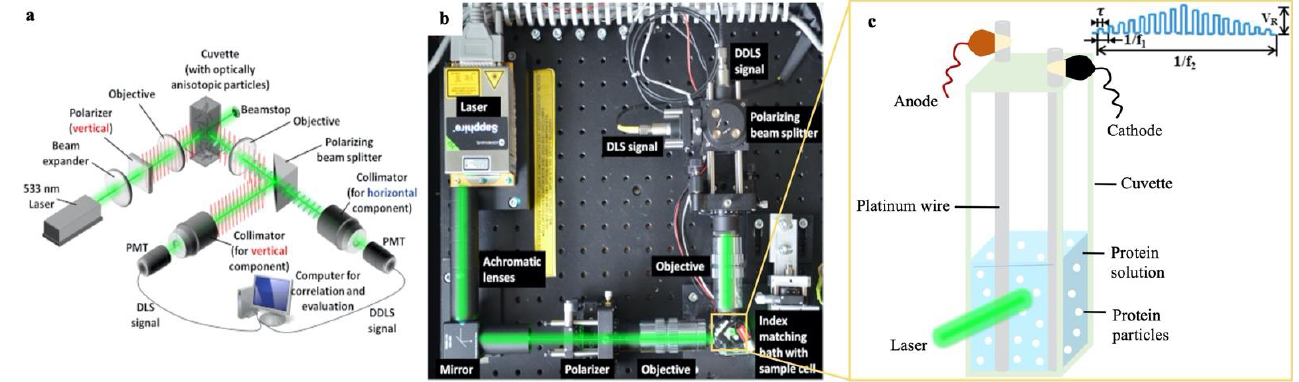
Figure 2. ( a ) Schematic [53] and ( b ) photographic [52] images of the DDLS instrument. ( c ) Illustra- tion of the quartz cuvette with two Pt wires to apply a pulsed electric field during a DLS/DDLS measurement [52].